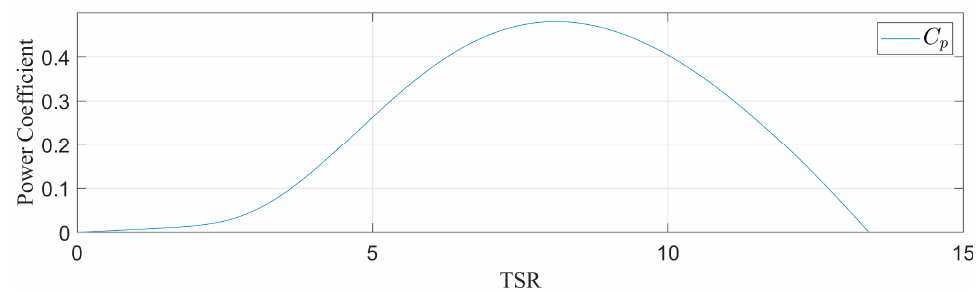
Figure 2. Example of the power coefficient as a function of the TSR.